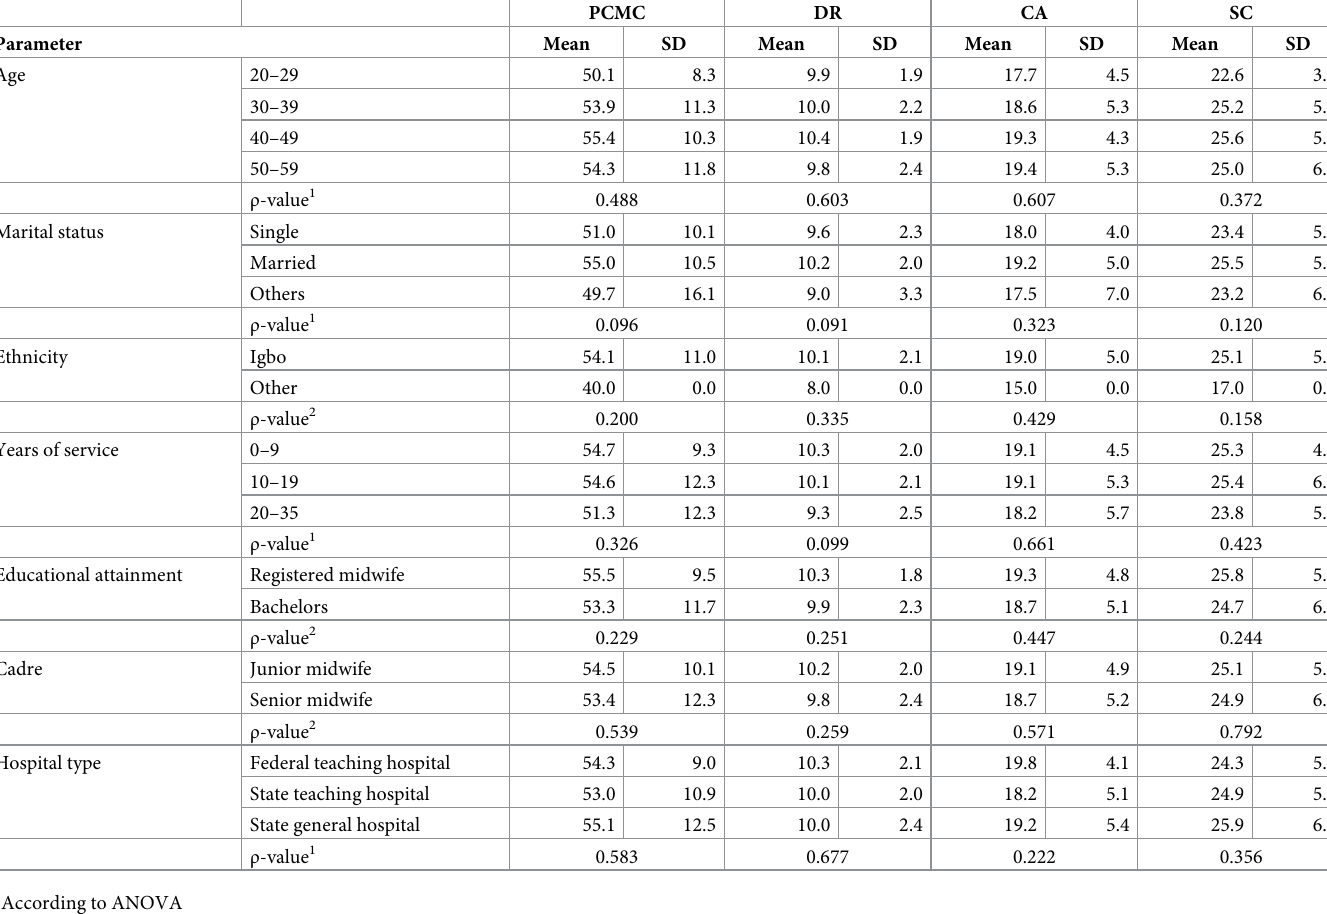
Table 6. Socio-demographic factors associated with midwives’ perception of person-centred maternity